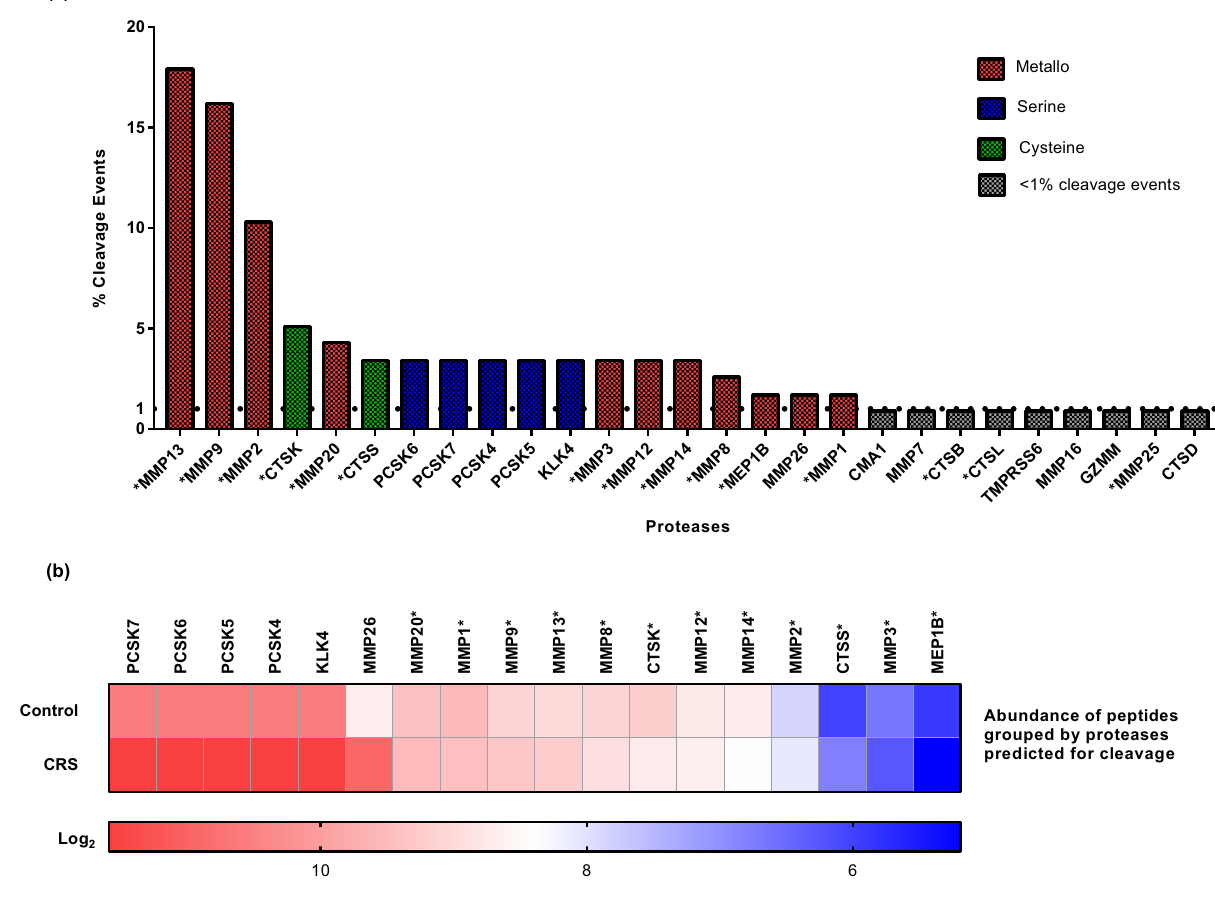
Figure 2. In silico predicted proteases. ( a ) The 27 predicted proteases are presented. Of these, 18 were linked to ≥ 1% of cleavage events and are highlighted in red, blue and green whereas 9 had < 1% of cleavage events (highlighted in grey). The 15 predicted proteases which were involved in the generation of the 193 CRS-specific peptides are marked with an asterisk. The catalytic mechanism of the shortlisted proteases is also depicted. ( b ) Heat map of the log 2 transformed abundance of the differentially excreted peptides predicted as substrates of 18 shortlisted proteases by the Proteasix. The predicted proteases which were associated with the 193 CRS-specific peptides are marked with an